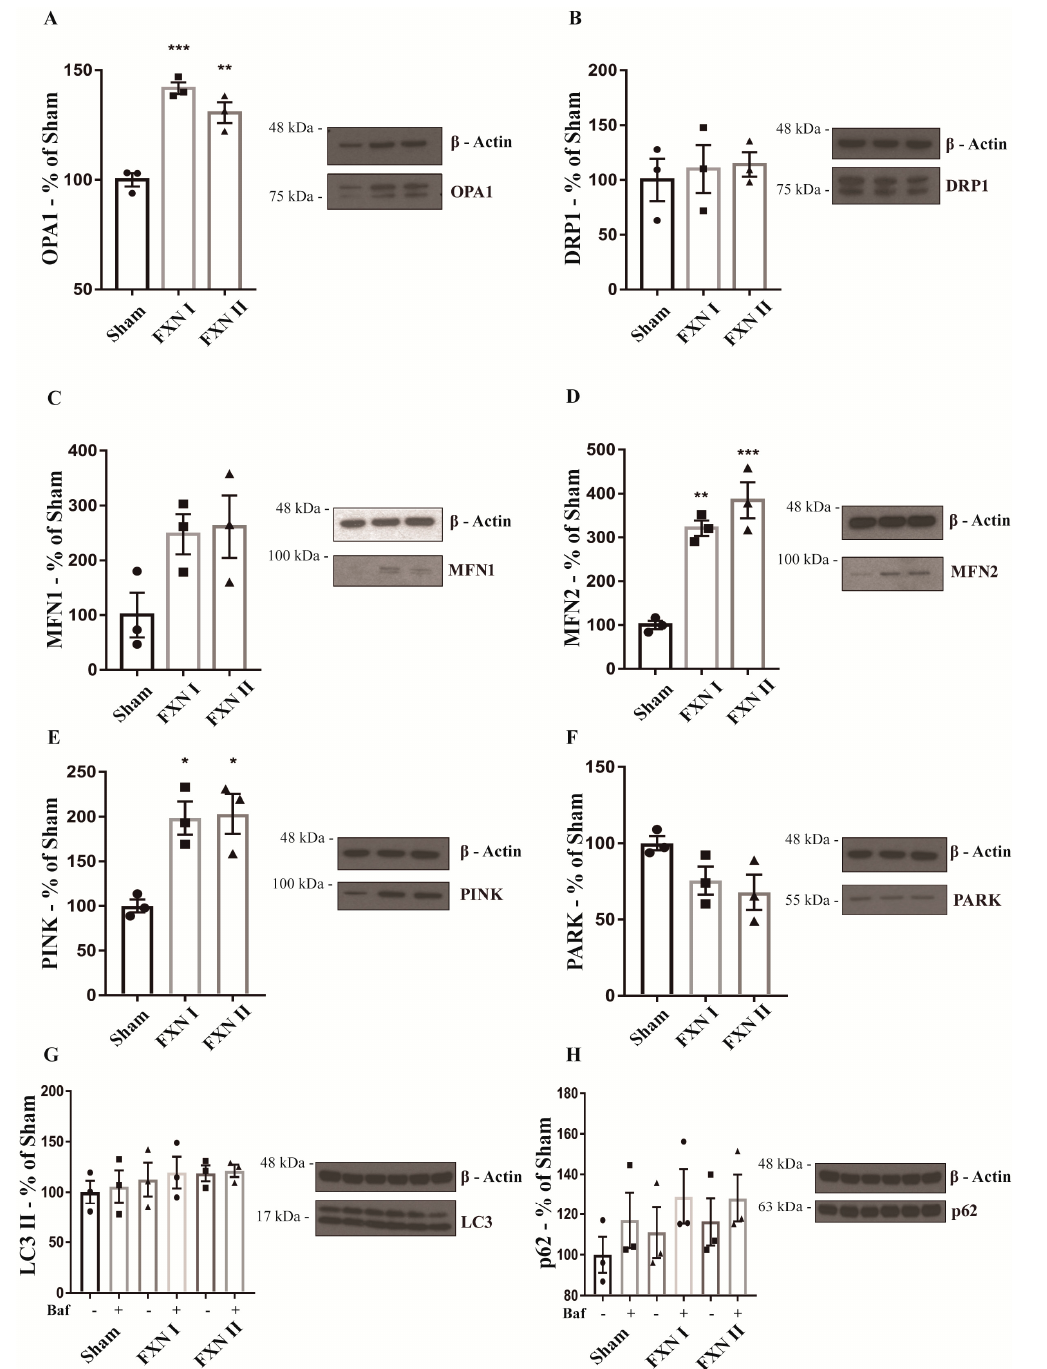
Figure 6. Western blot analysis of mitochondrial dynamics and quality control related proteins in FRDA fibroblast patient cells. Cells were either left untransduced (Sham) or transduced with Lv-FXN I or Lv-FXN II. ( A ) Analysis of OPA1 levels in fibroblast patient cells. ( B ) Analysis of DRP1 levels in fibroblast patient cells. ( C ) to ( D ) Analysis of MFN1 and MFN2 levels in fibroblast patient cells. ( E ) to ( F ) Analysis of PINK/PARK levels in fibroblast patient cells. ( G ) to ( H ) Analysis of LC3 and p62 levels with and without autophagy inhibitor bafilomycin A1. Data are represented as mean ± SEM and were analyzed with a one-way ANOVA with post hoc Dunnett multiple comparisons test with n = 3. * p < 0.05; ** p < 0.01; *** p <